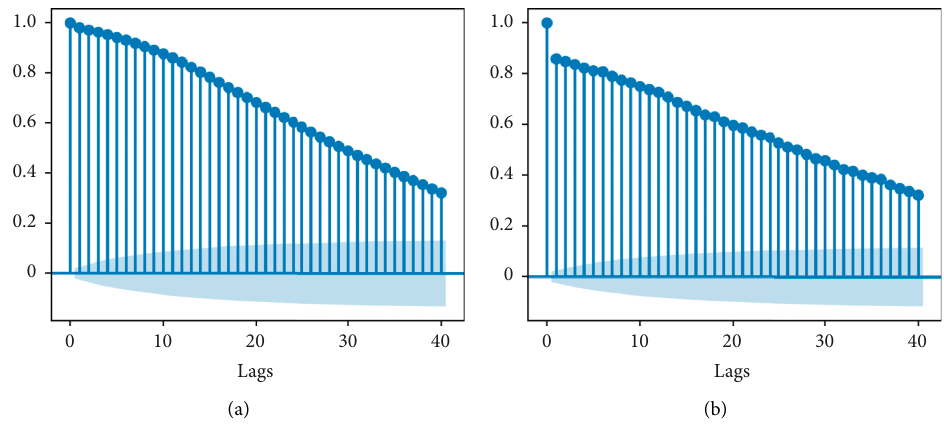
Figure 6: Autocorrelation of (a) 717490 and (b)